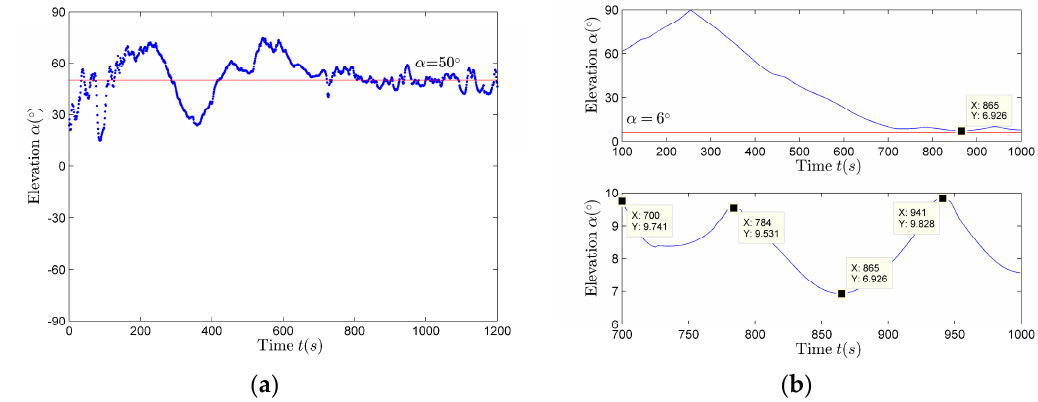
Figure 20. The elevation estimation results. ( a ) Elevation estimation results using the vertical sound intensity flow method; ( b ) Artwork and magnification of the elevation estimation results using the frequency sequence extraction method.